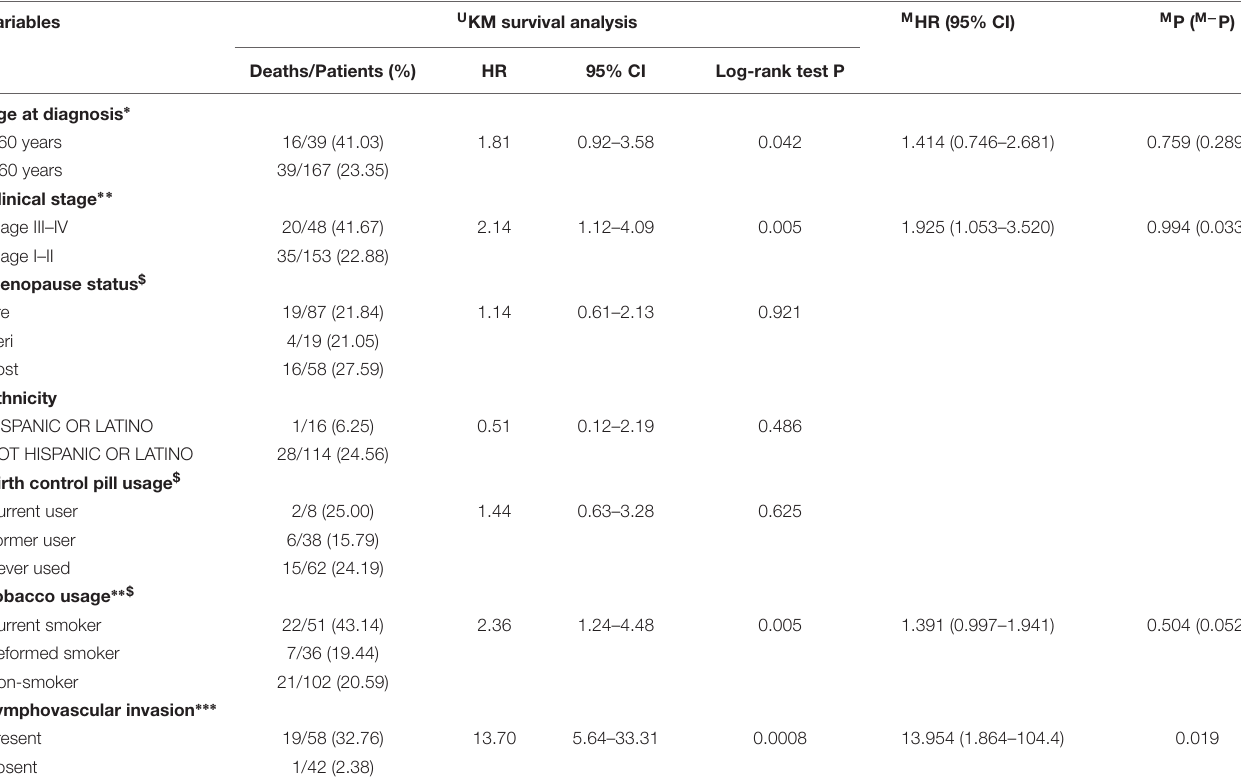
TABLE 1 | Patient characteristics, KM survival analysis, and MCA of demographic and clinicopathological